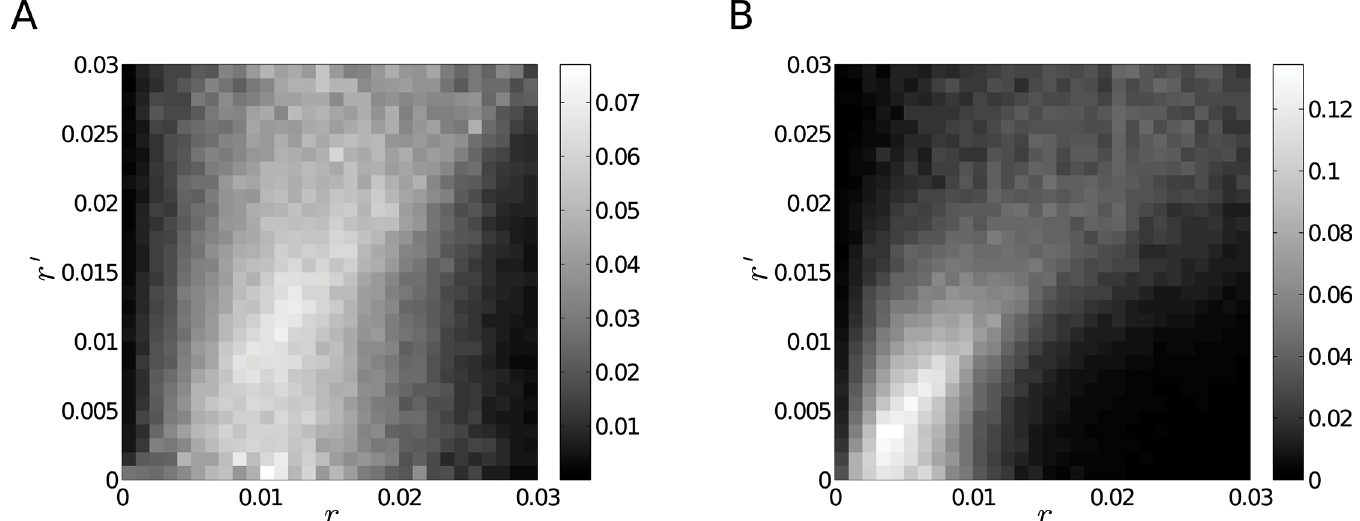
Fig 2. Conditional Probabilities of Edge Lengths for Random Data. The figures illustrate how the p ( r | r 0 ) conditional probability looks for randomly generated point positions. Panel A. Conditional probability of points with coordinates generated according to a uniform distribution. Panel B. Conditional probability of points with coordinates generated according to a mixture of uniform distribution and clusters of Gaussian distributions. In the latter example an emphasized diagonal is observed which is the result of the Gaussian clusters. Tightly packed points tend to produce short edges, while points from the edges of the clusters mostly have longer